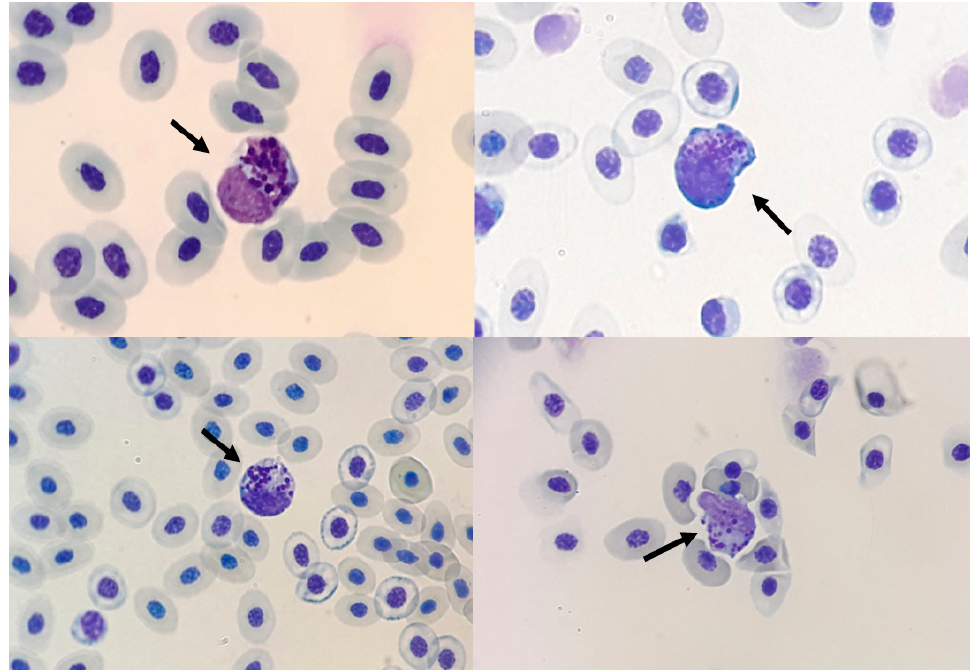
Figure 7. Unidentified granulocytes in blood smear stained with fast Panotico ® (arrow 100×).